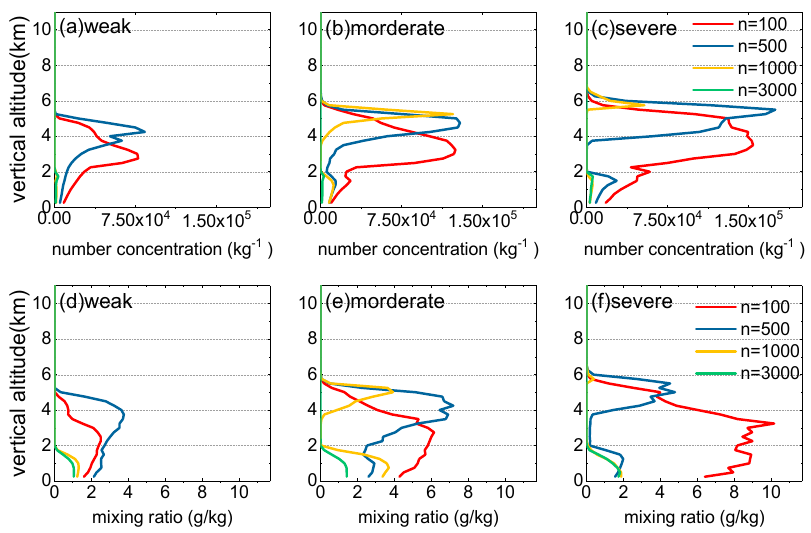
Figure 6. Vertical profiles of the maximum mixing ratio and the maximum number concentration of raindrops in ( a ) weak thundercloud, ( b ) moderate thundercloud, ( c ) severe thundercloud; the maximum number concentration of raindrop in ( d ) weak thundercloud, ( e ) moderate thundercloud, ( f ) severe thundercloud.